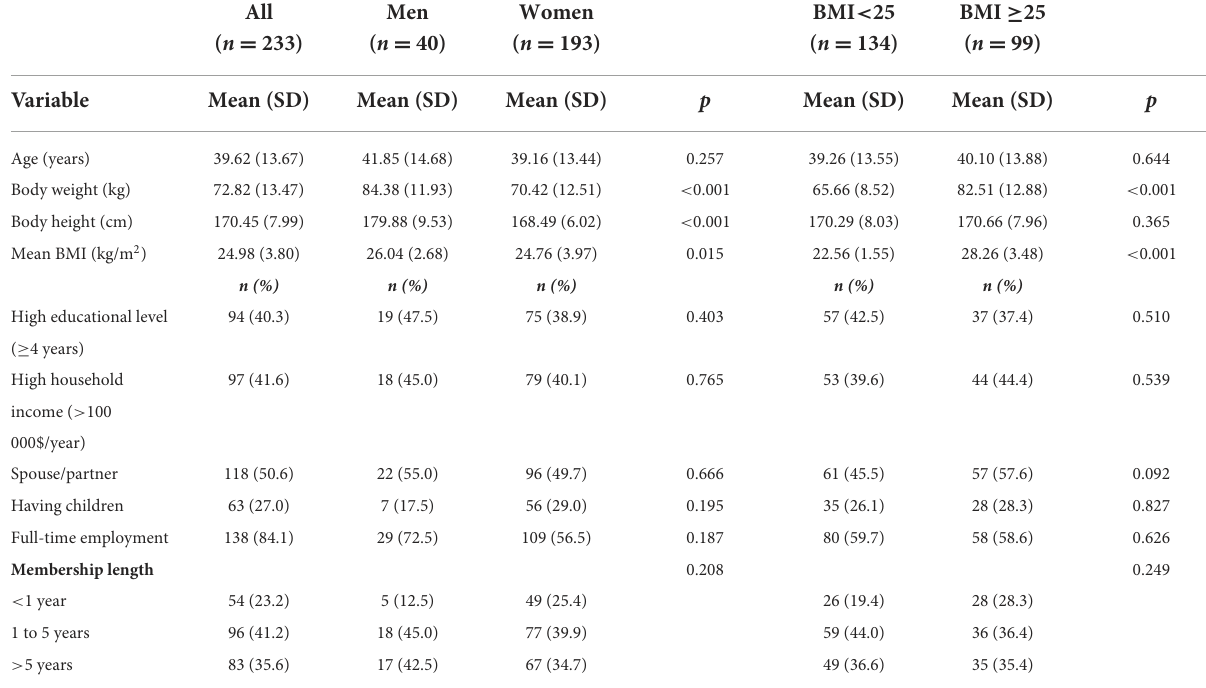
TABLE 2 General characteristics of